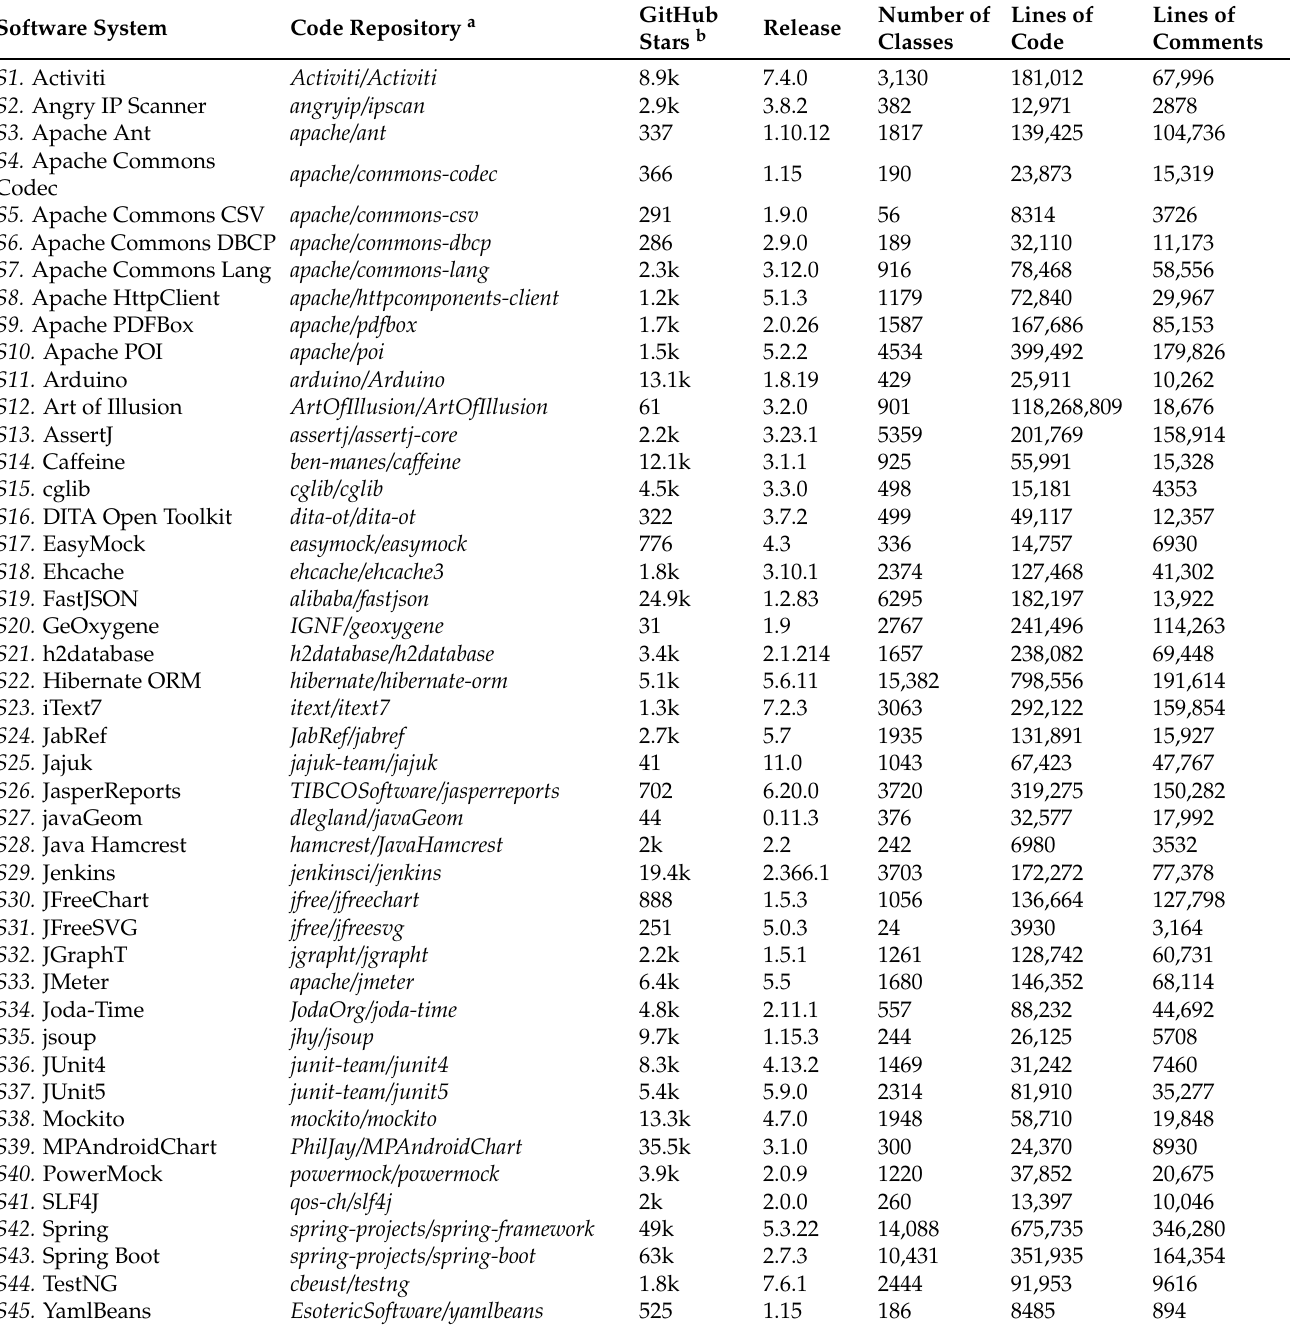
Table 4. Overview of subject software systems included in the study (RQ1 and